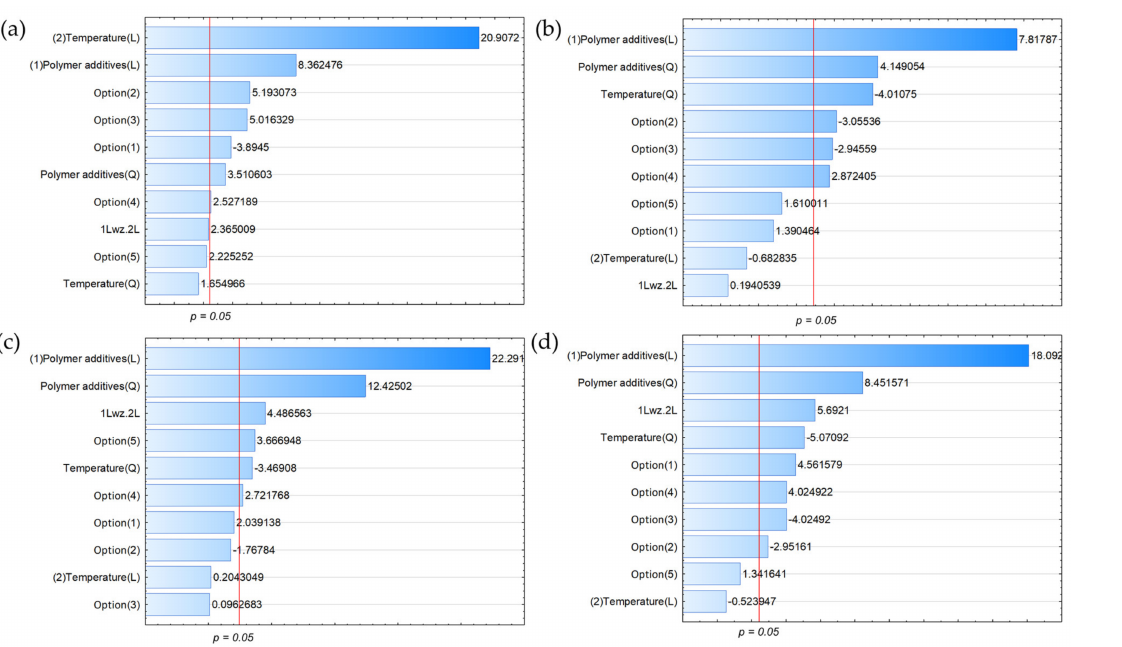
Figure 2. Pareto charts for ( a ) H 2 , ( b ) C 3 H 8 , ( c ) C 3 H 6 , and ( d ) C 4 H 10 (all variables characterised by bars exceeding the p = 0.05 limit had a statistically significant effect on the parameters under